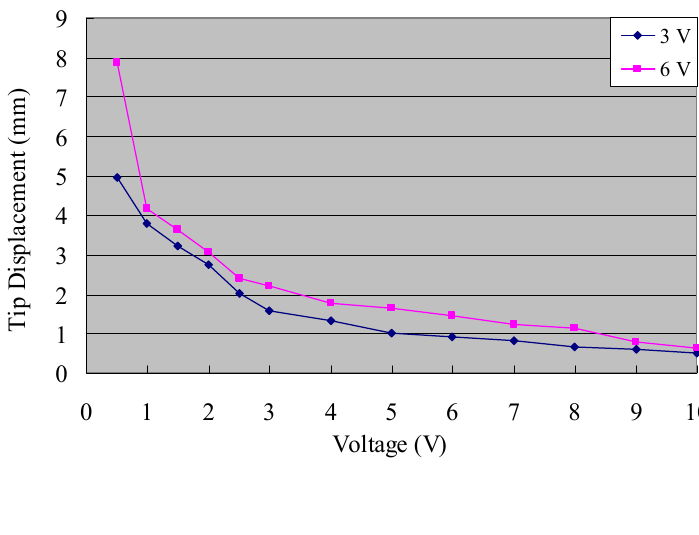
Figure 8. Tip displacements of the IPMC